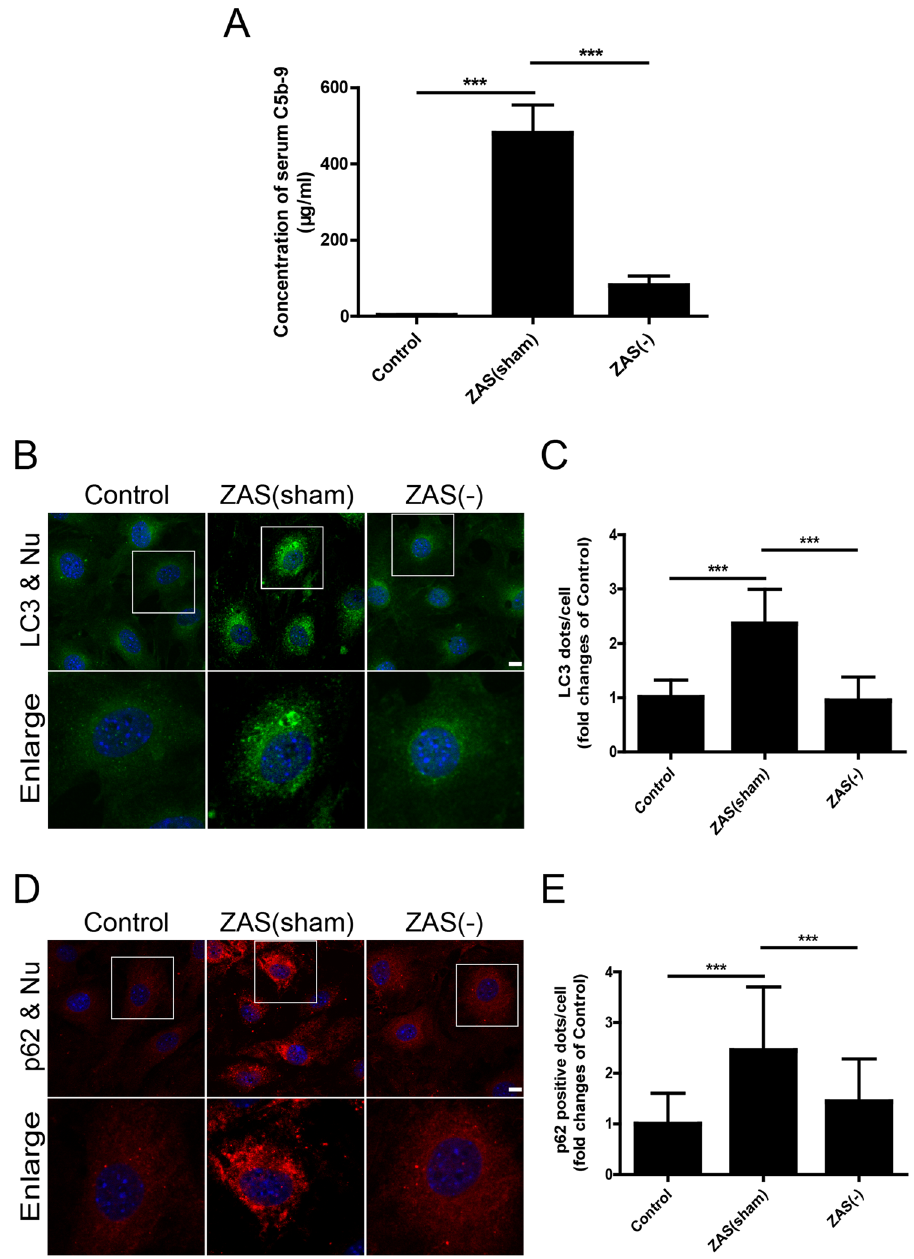
Figure 6. C5b-9-dependent autophagic changes after exposure of podocytes to zymosan activation serum (ZAS). ( A ) The results from enzyme-linked immunosorbent assay showed that the C5b-9 level of ZAS(sham) was higher than that in heat-inactivated human serum (HIS, as the control). However, the level of C5b-9 in ZAS( − ) was significantly lowered compared to ZAS(sham). ZAS( − ) indicated that C5b-9 was depleted in serum via incubation with anti-human C5b-9 monoclonal antibody for the indicated time period. ZAS(sham) indicated samples of ZAS prepared by an identical method. ( B , C ) Representative fluorescence images of LC3 (green) and DAPI (blue) staining revealed the number of LC3-positive puncta was significantly increase in podocytes after exposure to ZAS(sham) for 4 h but was abolished by ZAS( − ). ( D , E ) Representative fluorescence images of p62 (red) and DAPI (blue) staining showed p62-positive aggregates in ZAS(sham)-treated podocytes, which was not observed in ZAS( − )-treated podocytes at 4 h. All the fluorescence images were obtained using a confocal microscope. Scale bar, 10 μ m. The data are mean ± SD. *** P <